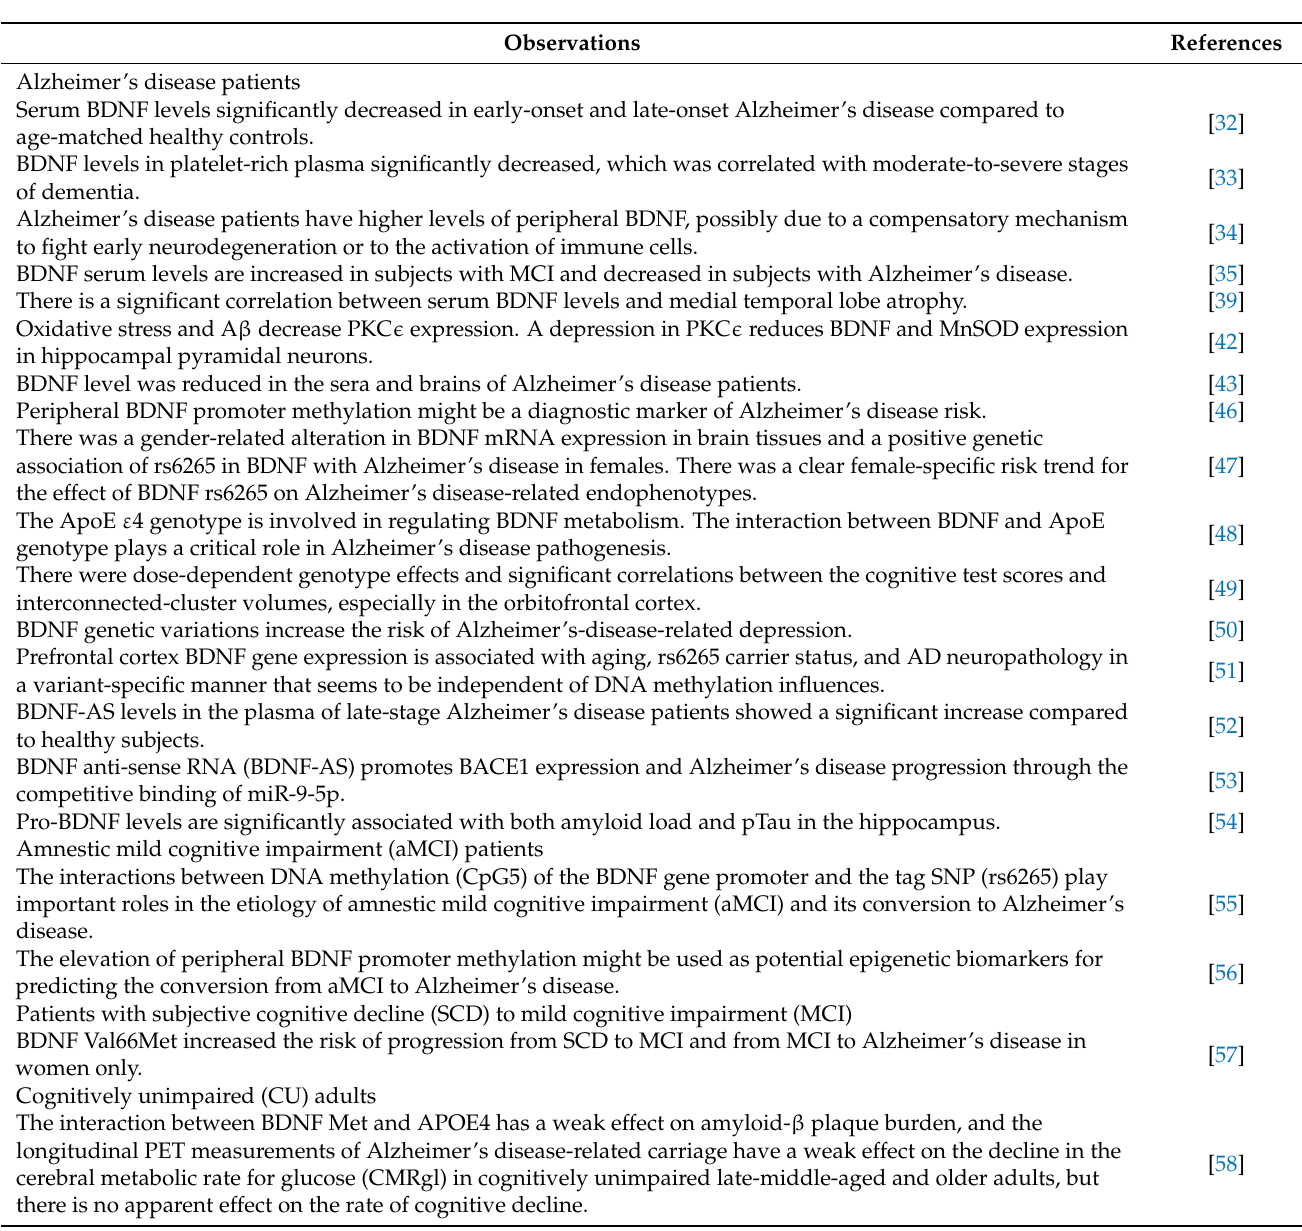
Table 1. Role of BDNF in Alzheimer’s